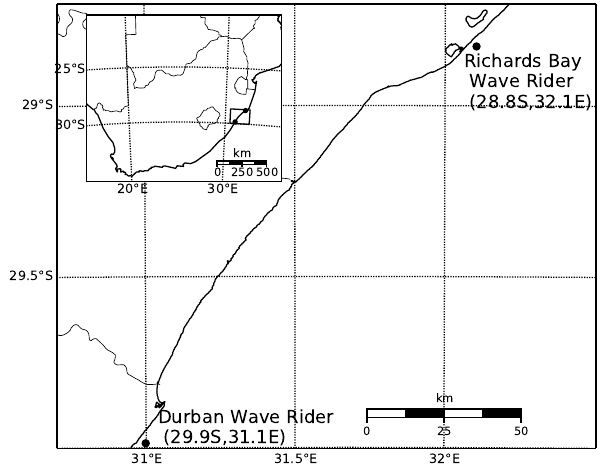
Figure 1. Locations of the wave observation buoys at Durban and Richards Bay, along the KwaZulu-Natal